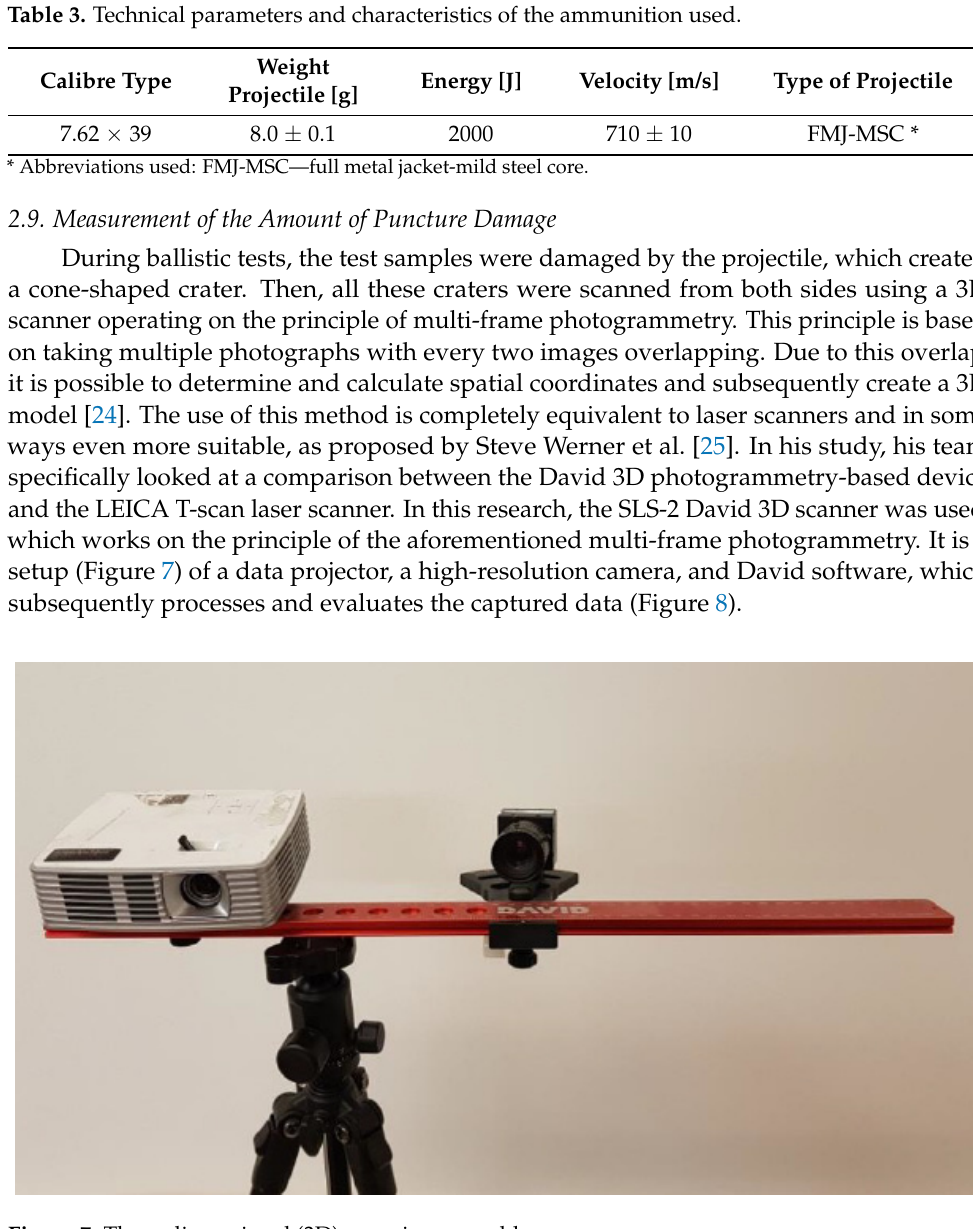
Table 3. Technical parameters and characteristics of the ammunition used.